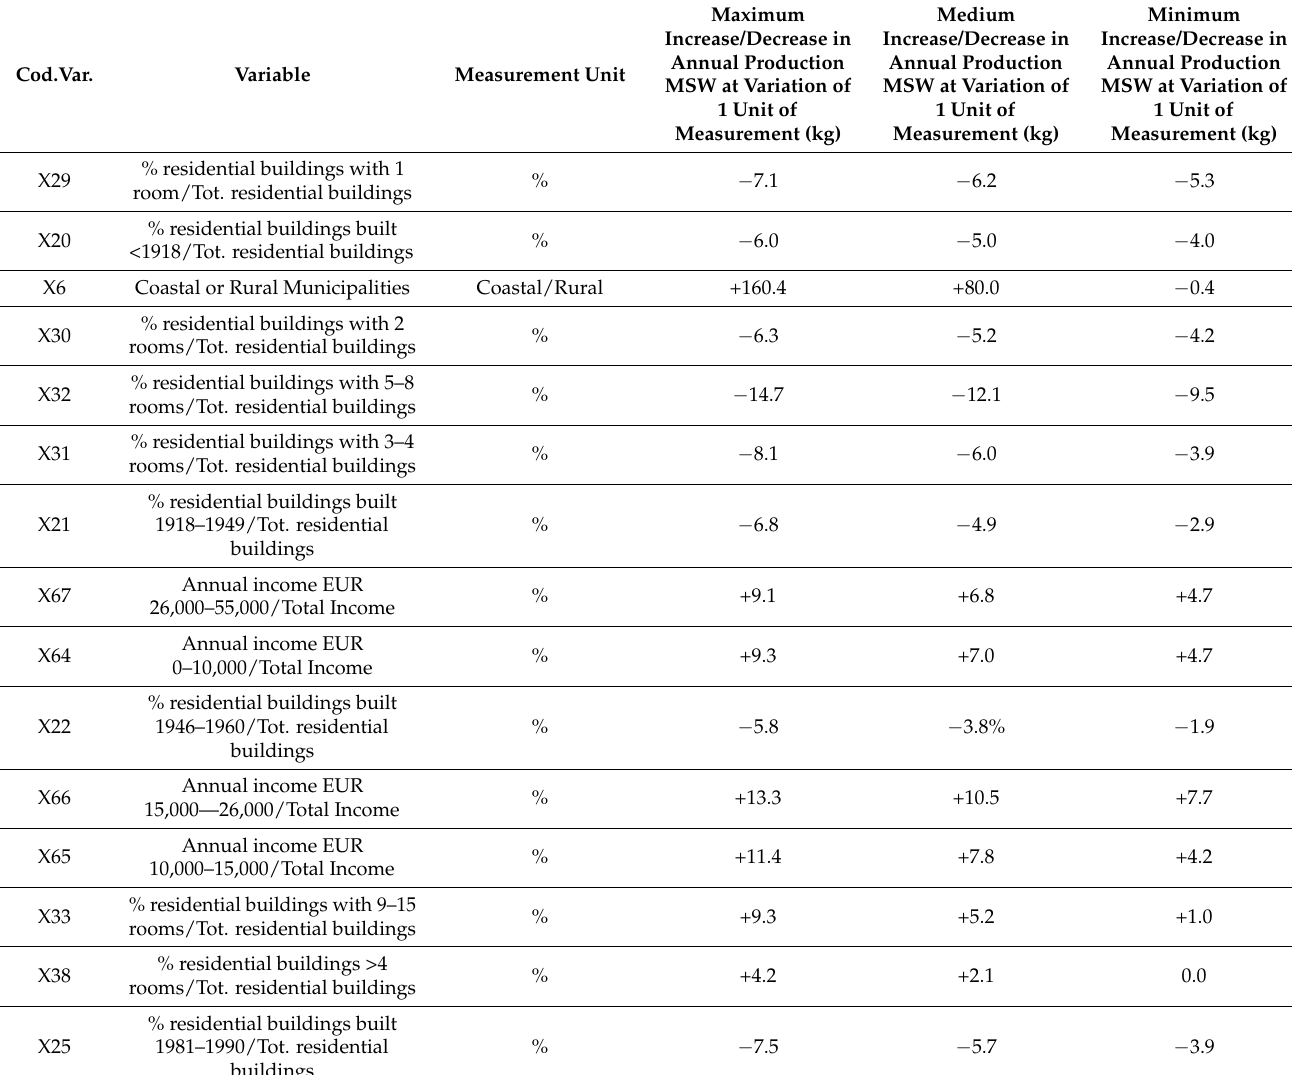
Table 1. Annual per capita waste production: Range of the average increase/decrease per unit of measurement of each of the 15 variables shown in Figure